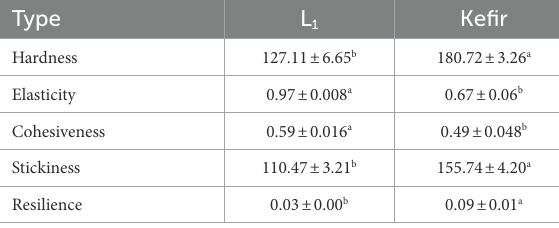
TABLE 2 Effects of L 1 and kefir groups on the texture of